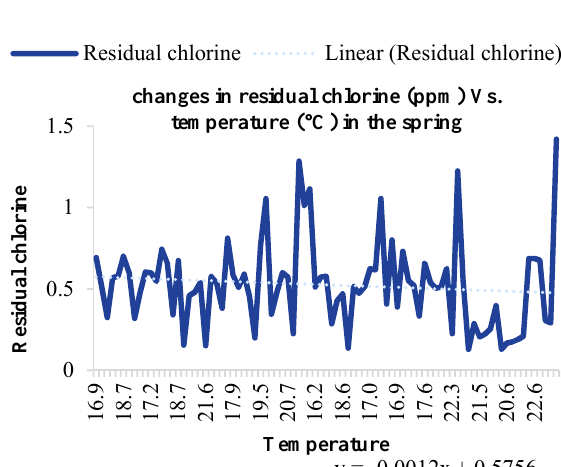
Figure 5. Average turbidity in the winter and spring